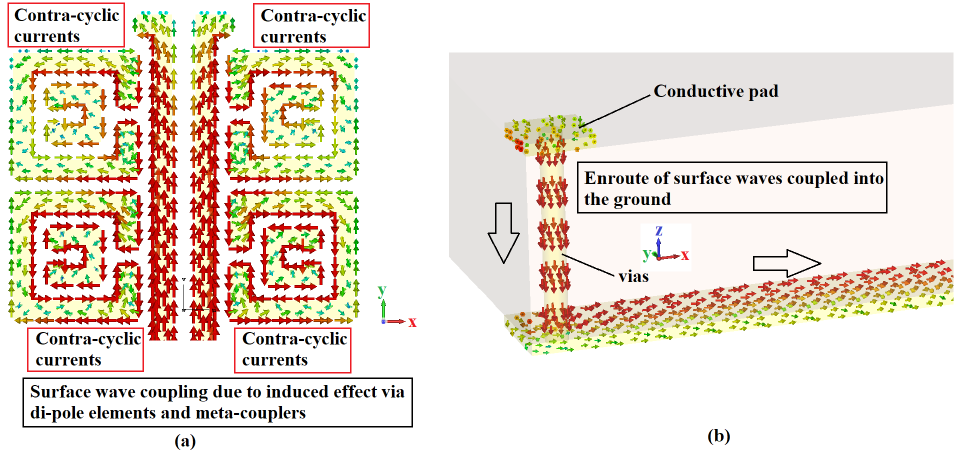
Figure 11. ( a ) Surface wave coupling process and ( b ) metallic vias’ effect on the case of the proposed four-element antenna configuration.